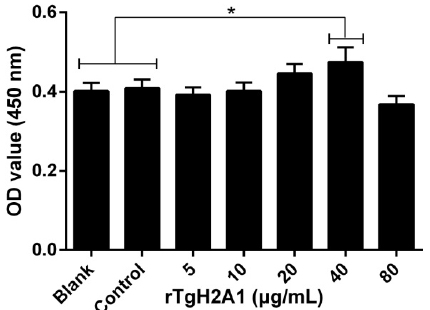
Figure 3. Effects on proliferation of different concentrations (0, 5, 10, 20, 40, and 80 μg/mL) of rTgH2A1 on the murine macrophages. The proliferation assay was performed using the CCK-8 reagent kit. The cell proliferation index was calculated using the OD450 values. The Ana-1 cells in the blank groups were treated with PBS while those in the control group were treated with his-tagged protein. Results were evaluated using one-way ANOVA analysis followed by Dunnett’s test and expressed as mean ± standard deviation of three independent experiments. * p < 0.05 compared with the blank or control group.